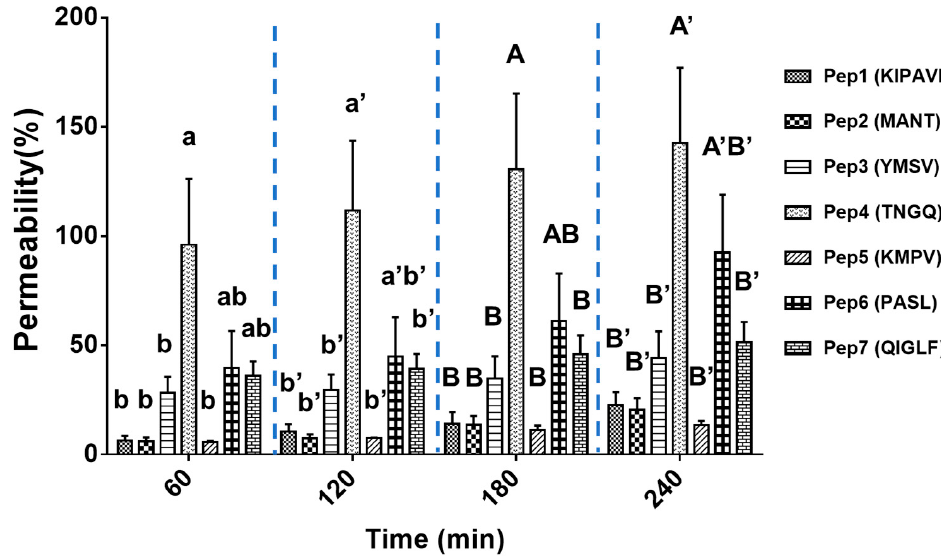
Figure 4. Biosimilar mucus-permeating property of peptides at 60, 120, 180, and 240 min that was quantified by a simple and efficient in vitro cell-free model established in this study. One-way analysis of variance was performed within each time point, and different letters indicate significantly different mean values ( p < 0.05).